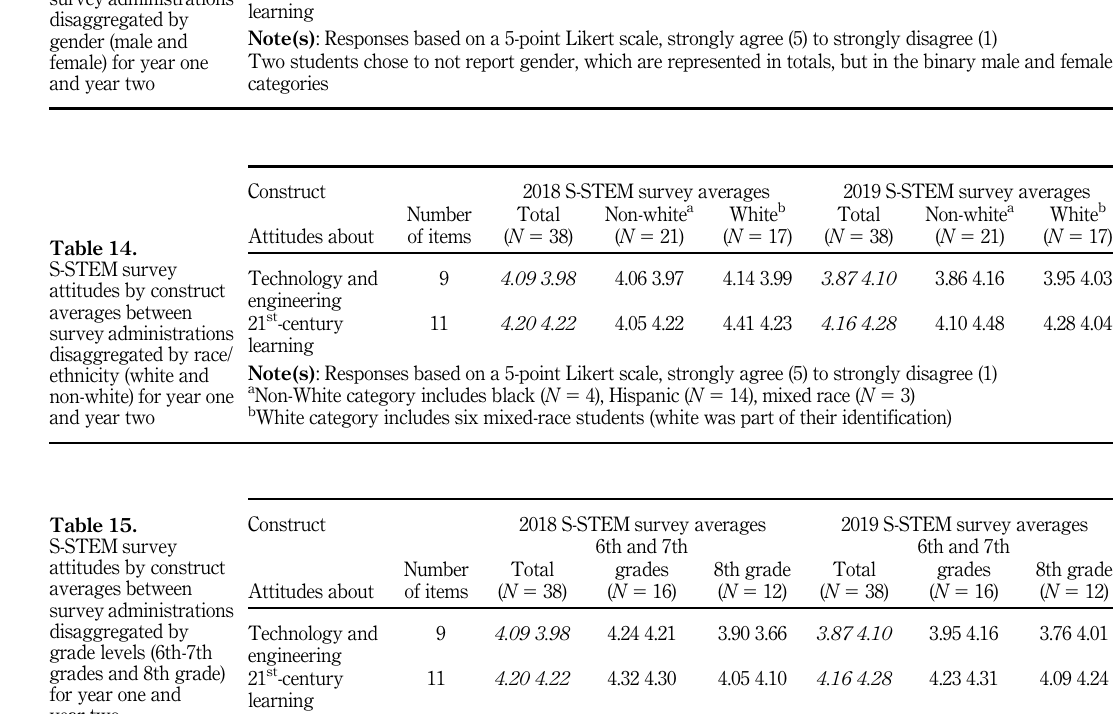
Table 13. S-STEM survey attitudes by construct averages between survey administrations disaggregated by gender (male and female) for year one and year two